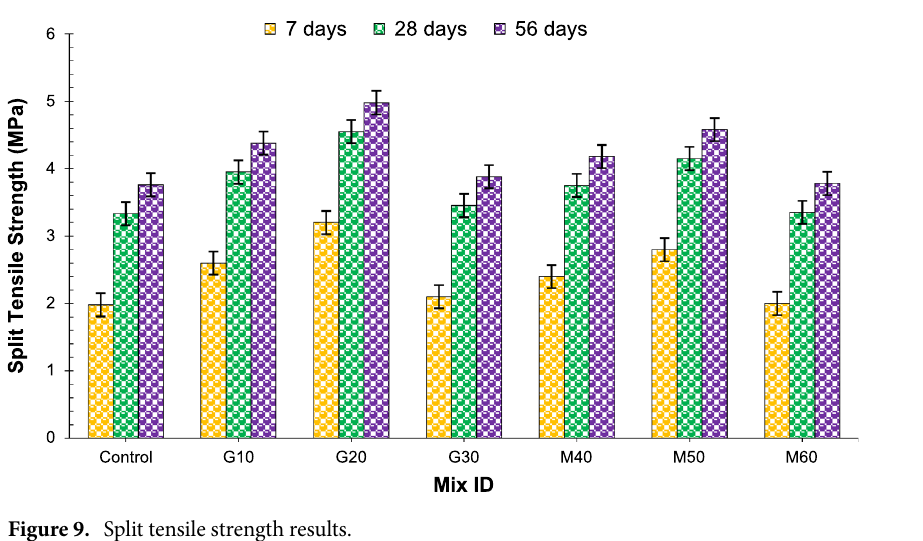
Figure 9. Split tensile strength